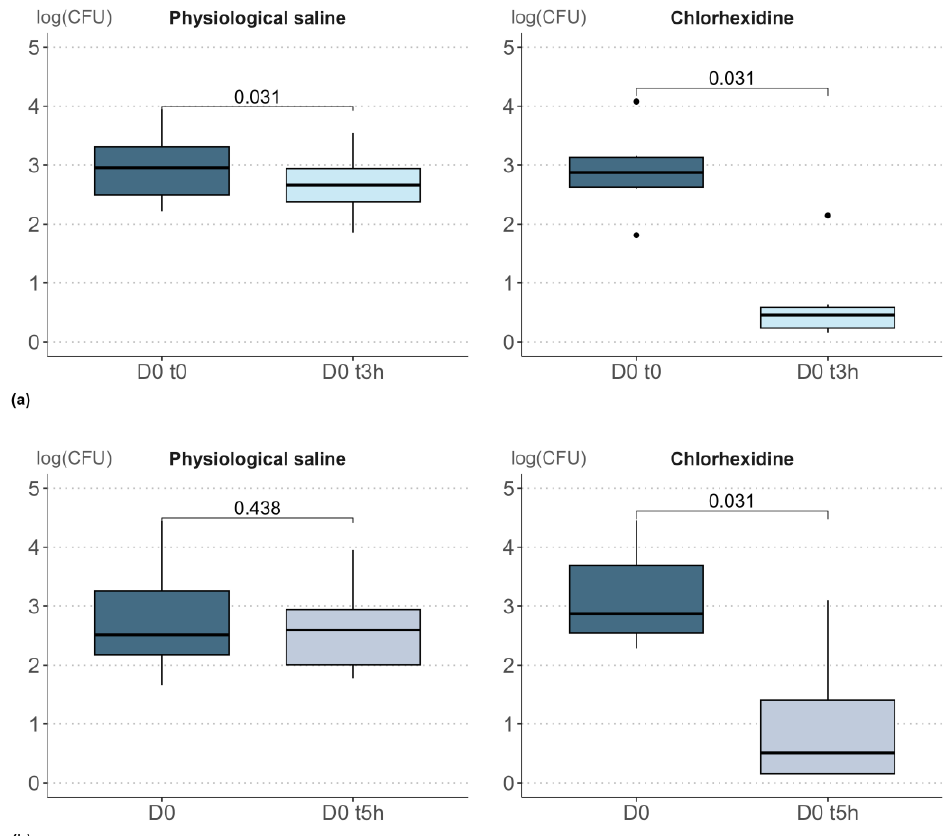
Figure 1. Boxplot representation of results obtained after a single topical application of physiological saline or chlorhexidine (log-transformed bacterial densities): ( a ) Study 1, sampling 3 h after application, ( b ) Study 2, sampling 5 h after application. Adjusted two-tailed Wilcoxon signed-rank test (α 0.05), p < 0.05 indicates statistically significant results. In the boxplot, the dots represent the outliers. The outiliers are defined as the values below Q1 − 1.5 IQR and the values above Q3 + 1.5 * IQR; Q1 and Q3 are the first and the third quartile, respectively, IQR is the interquartile range (Q3–Q1).